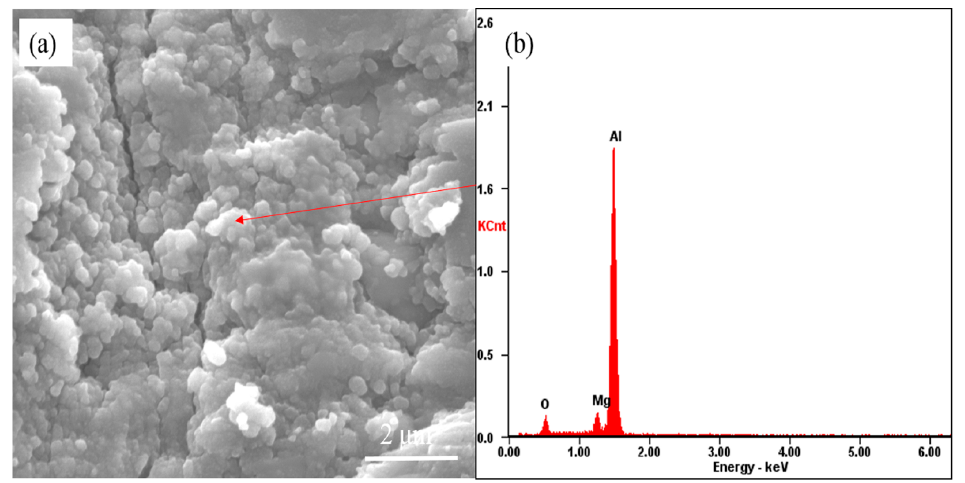
Figure 4. ( a ) The surface micro-morphology of A356 alloy scraps; ( b ) Corresponding EDS results.